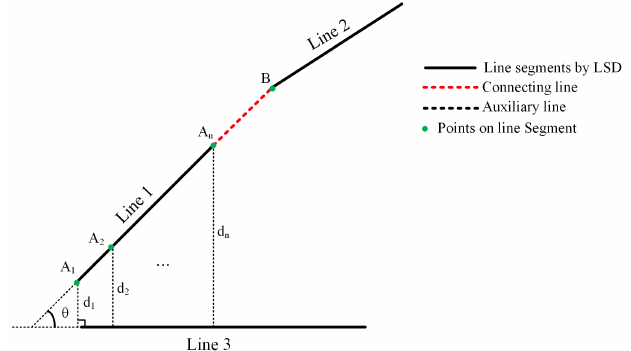
Figure 5. Sketch map for line segment pair connection.